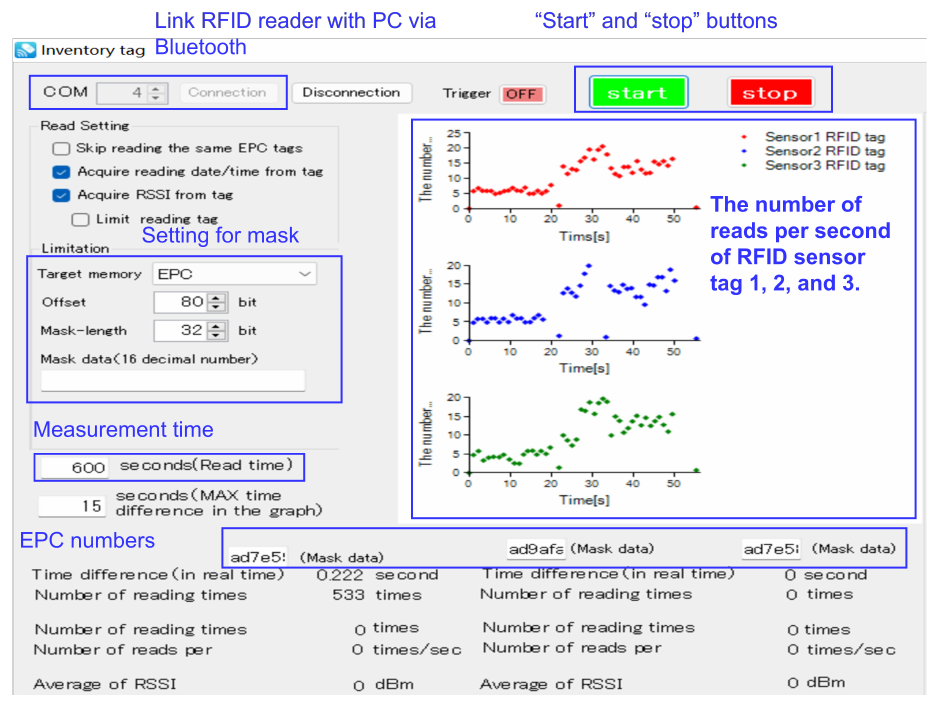
Figure 4. Developed RFID reader software implementing the proposed edge